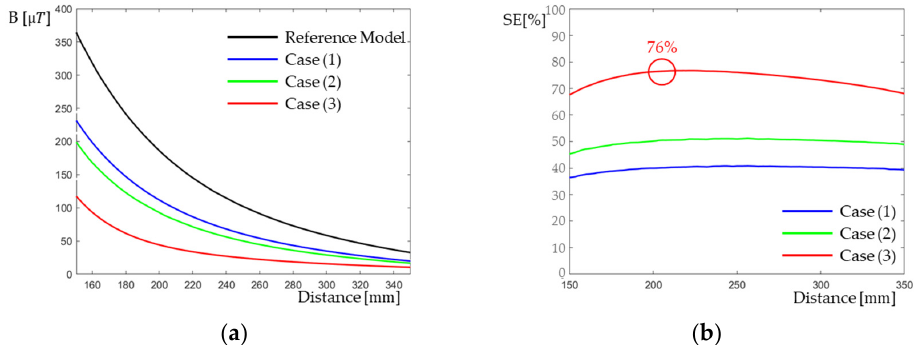
Figure 15. Comparison according to the model. ( a ) Comparison of the leakage magnetic field. ( b ) Comparison of the shielding effect.